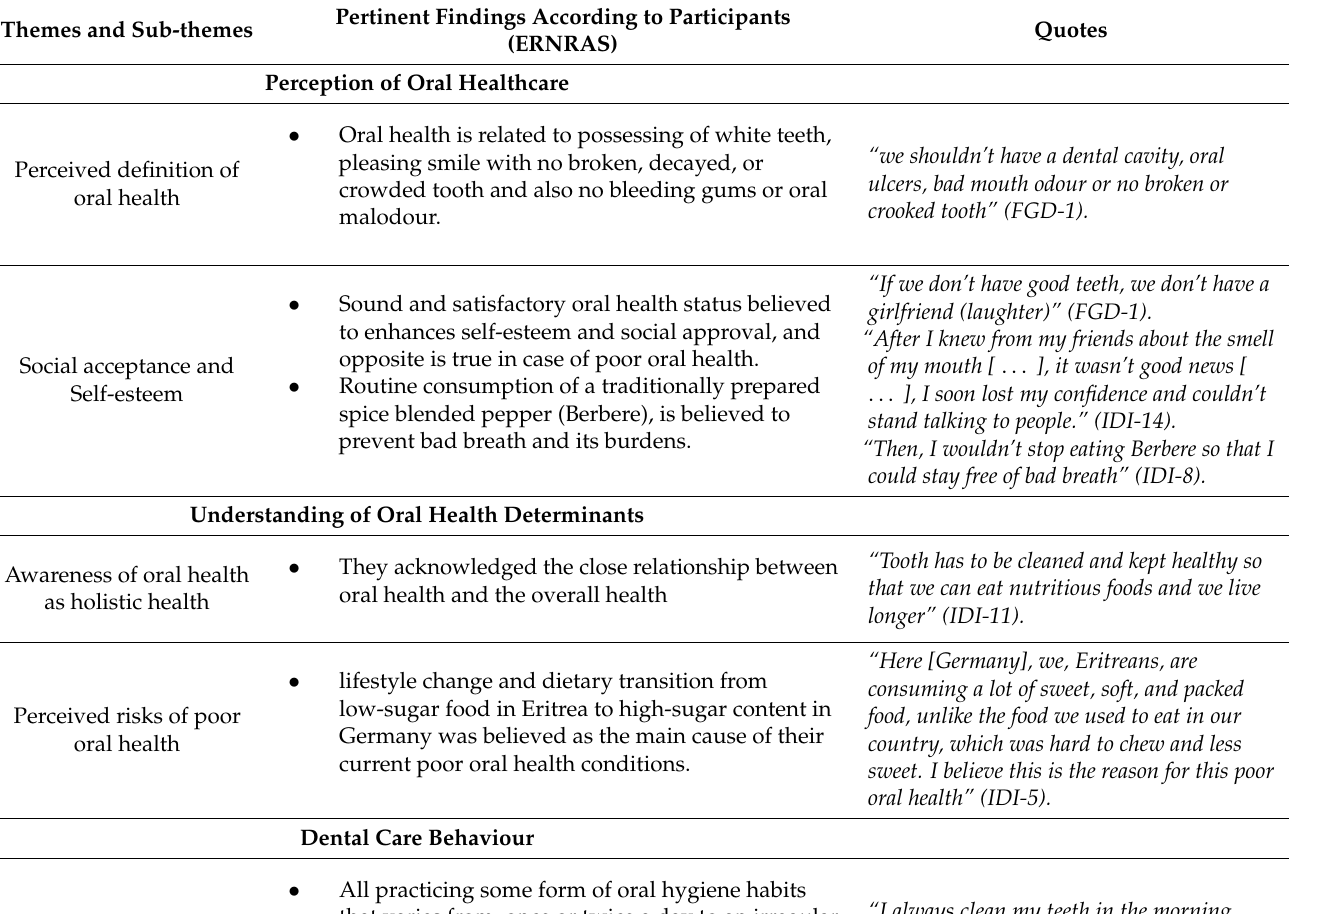
Table A2. Themes, sub-themes, and exemplar